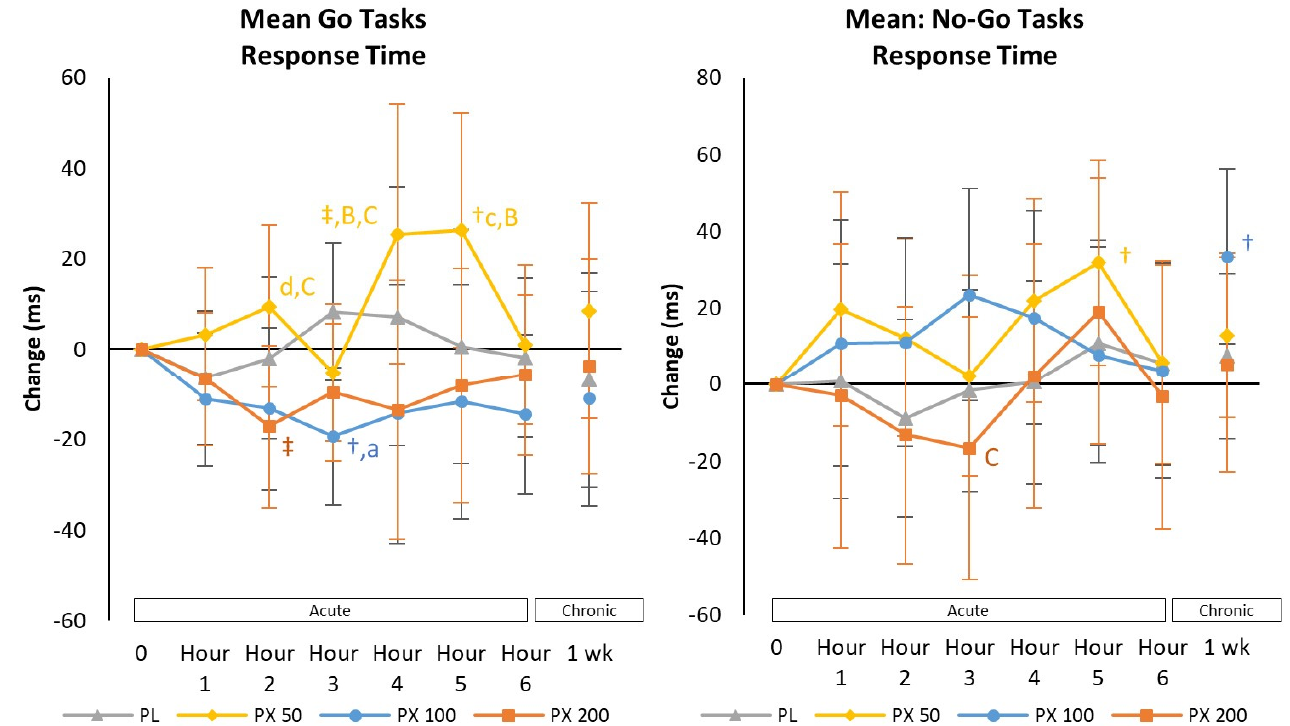
Figure 4. Mean changes from baseline with 95% confidence intervals in Go and No-Go task response times. † = p < 0.05 (‡ = p > 0.05 to p < 0.10) from baseline. 1† = p < 0.05 from Day 1–1 h value. Treatment differences are denoted as from PLA: a = p < 0.05 (A = p > 0.05 to p < 0.10); PXN 50: b = p < 0.05 (B = p > 0.05 to p < 0.10); PXN 100: c = p < 0.05 (C = p > 0.05 to p < 0.10); and PXN 200: d = p < 0.05 (D = p > 0.05 to p < 0.10).